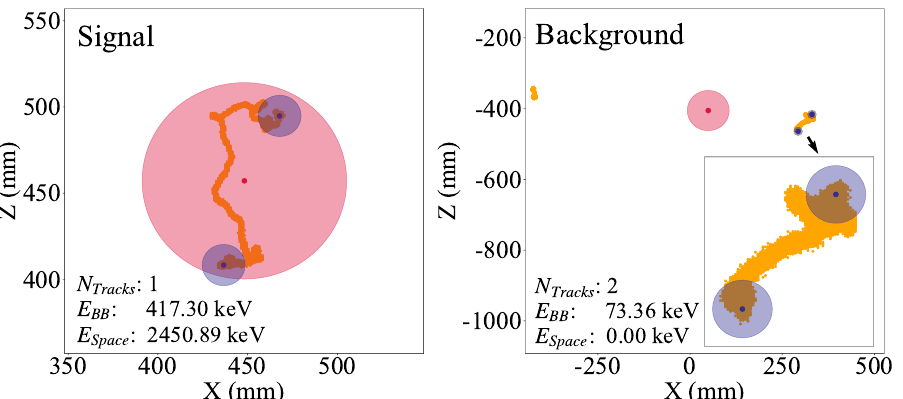
Figure 4. Examples of 0 νββ signal (left) and γ background (right) tracks in the XZ plane for illustrating N Tracks , E BB , and E Space . The red circles centered at the charged centers of the events denotes the sphere within which E Space is evaluated. Blob energies are calculated within the blue spheres are the estimated endpoints of the principle tracks. E BB shown in the figure are the smaller blob energy at two ends. The inset in the right figure shows an enlarged view of the principal track of the